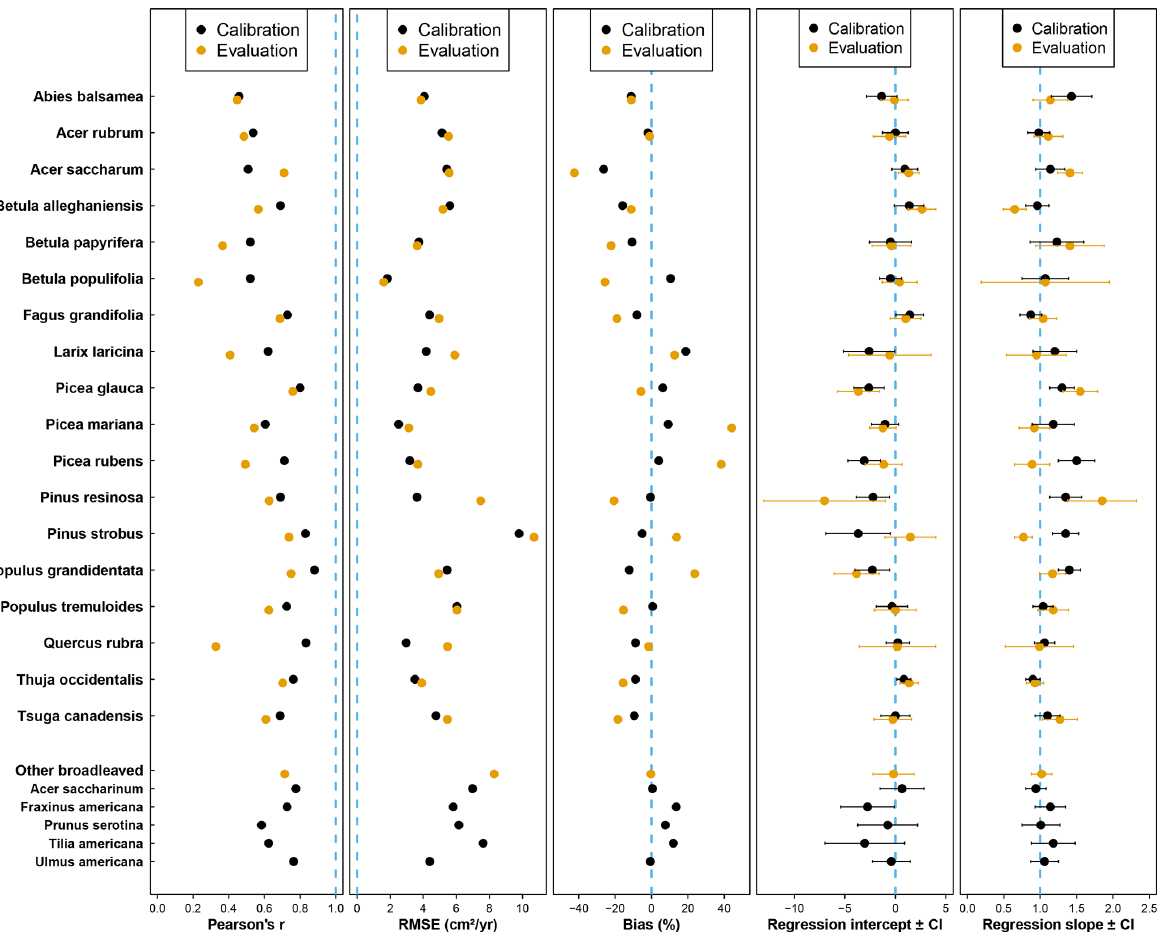
Figure 3. Statistical parameters (from left to right: Pearson’s correlation coefficient, root-mean-square error, relative bias, intercept, and slope of the Deming regression) assessing the performance of the model for each species using the calibration (black dots) or the evaluation (yellow dots) dataset. The dotted blue line indicates the best agreement between observations and predictions for each